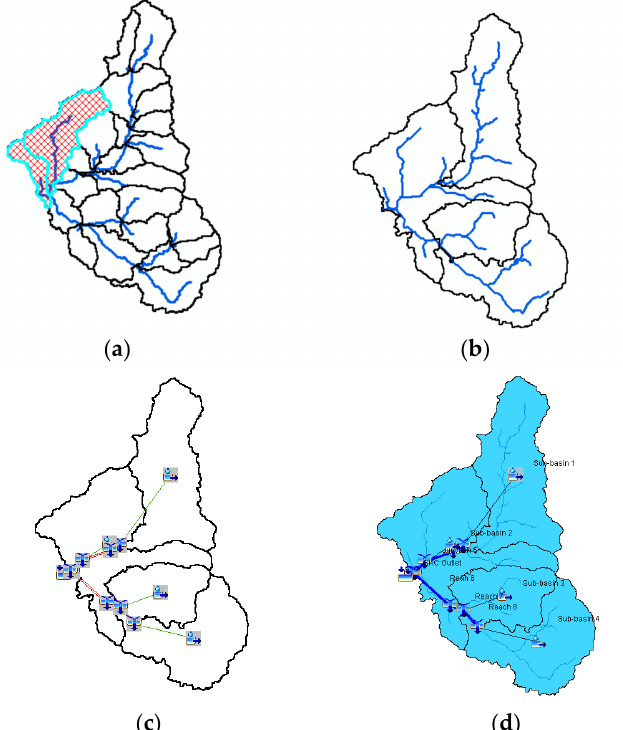
Figure 4. Hydrologic Engineering Corps Hydrologic Modeling System (HEC-HMS) model development processes for upper Bernam river watershed: ( a ) basin merge, ( b ) basin river network, ( c ) HMS-node, and ( d ) HMS basin model. Table 2. Characteristics of delineated sub-basins of Bernam watershed. Sub-Basin